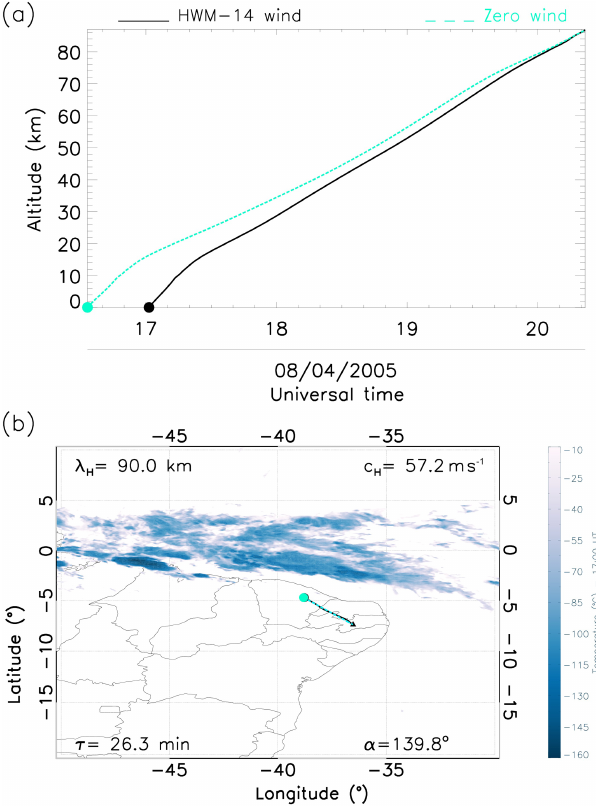
Figure 4. Reverse ray-tracing results for GW 1 . (a) Altitude as a function of time: dashed cyan and solid black lines show the ray paths for the zero winds and modelled winds respectively as well as the time cross section with zero wind and modelled winds. (b) Latitude–longitude cross section over convective cloud activi- ties: black and cyan dots show the location of sources for zero winds and modelled winds respectively; the black triangle represents the exact location of the ASI, and the dark blue plumes represent con- vective activities in the